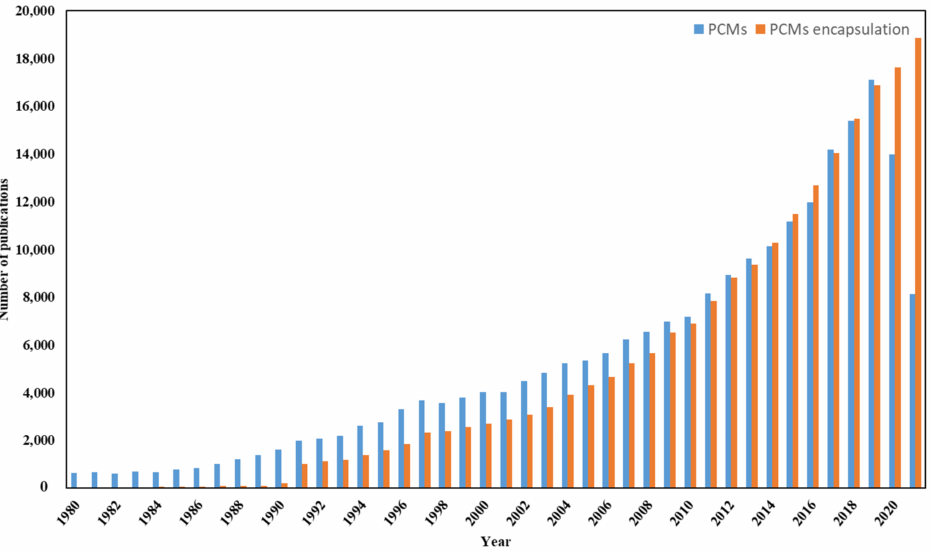
Figure 1. Trends in scientific articles on phase change materials and their encapsulation techniques (realized on Web of Science in 2021, advanced search): TS = (microcapsule OR microencapsulation OR nanoencapsulation OR encapsulation AND Phase AND Change AND Materials) TS = (PCM OR Phase Change